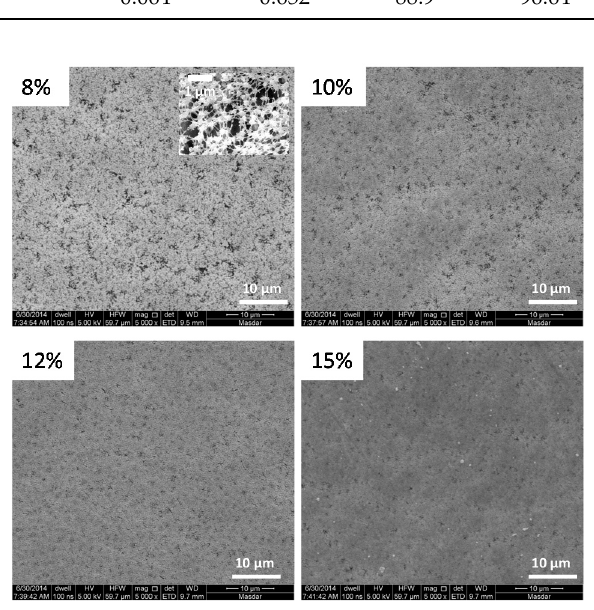
Figure 4. Surface SEM images of membrane samples prepared using polymer solutions of different PVDF concentrations (casting thickness: 500 μ m, RH: 60%, exposure time: 30 min).